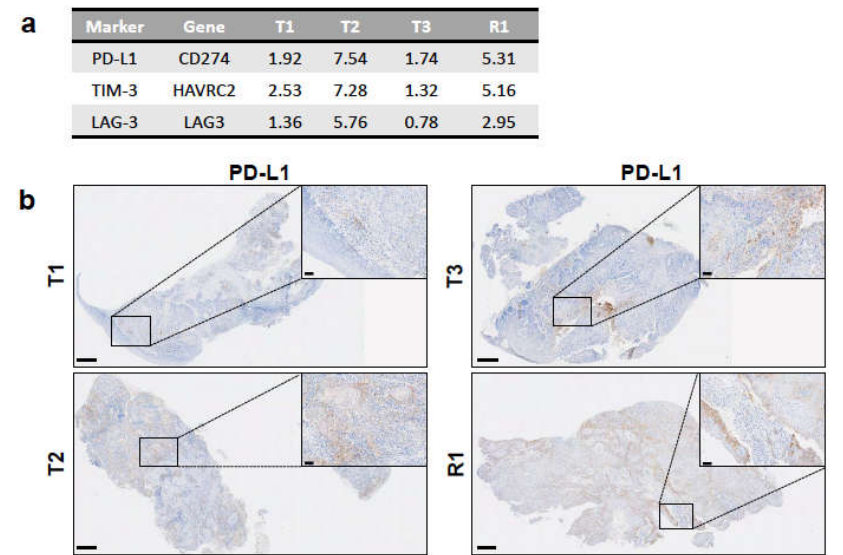
Figure 5. Expression of immunosuppressive markers among tumour samples. ( a ) Expression levels of genes encoding for the immunosuppressive markers PD-L1, TIM-3, and LAG-3 from RNA-seq data as RPKM values. ( b ) PD-L1 expression in each tumour sample as determined by IHC with anti-PD-L1 antibody on FFPE sections. Insets depict positively stained tumor cells in T2 and R1 and immune cells in T1 and T3 (see Results). Scale bars: 500 μm for full-size images and 50 μm for in- sets.